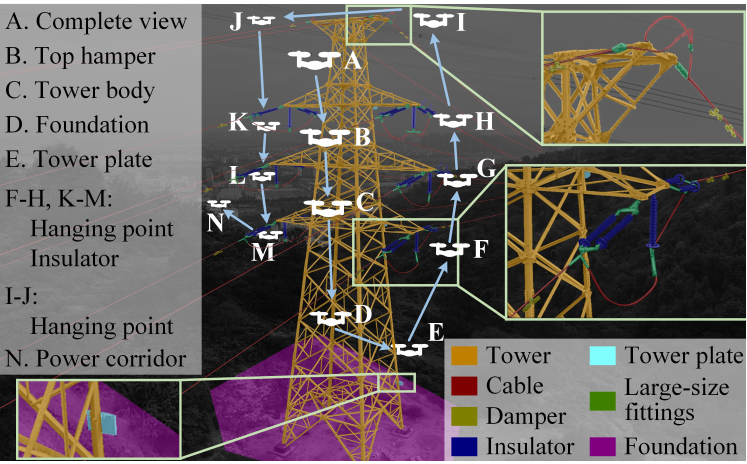
Figure 2. UAV proximity transmission tower inspection diagram.